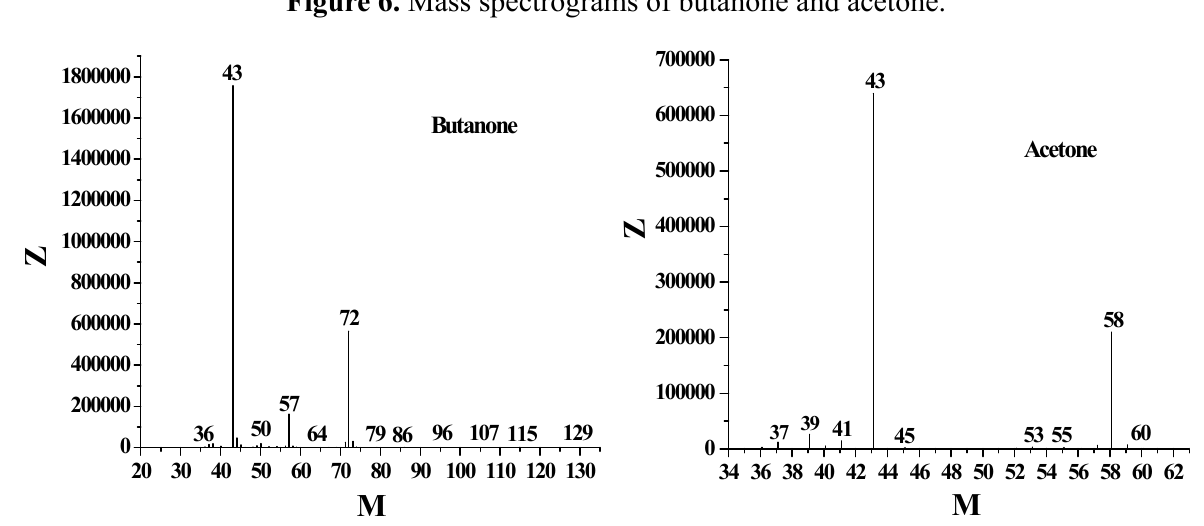
Figure 6. Mass spectrograms of butanone and